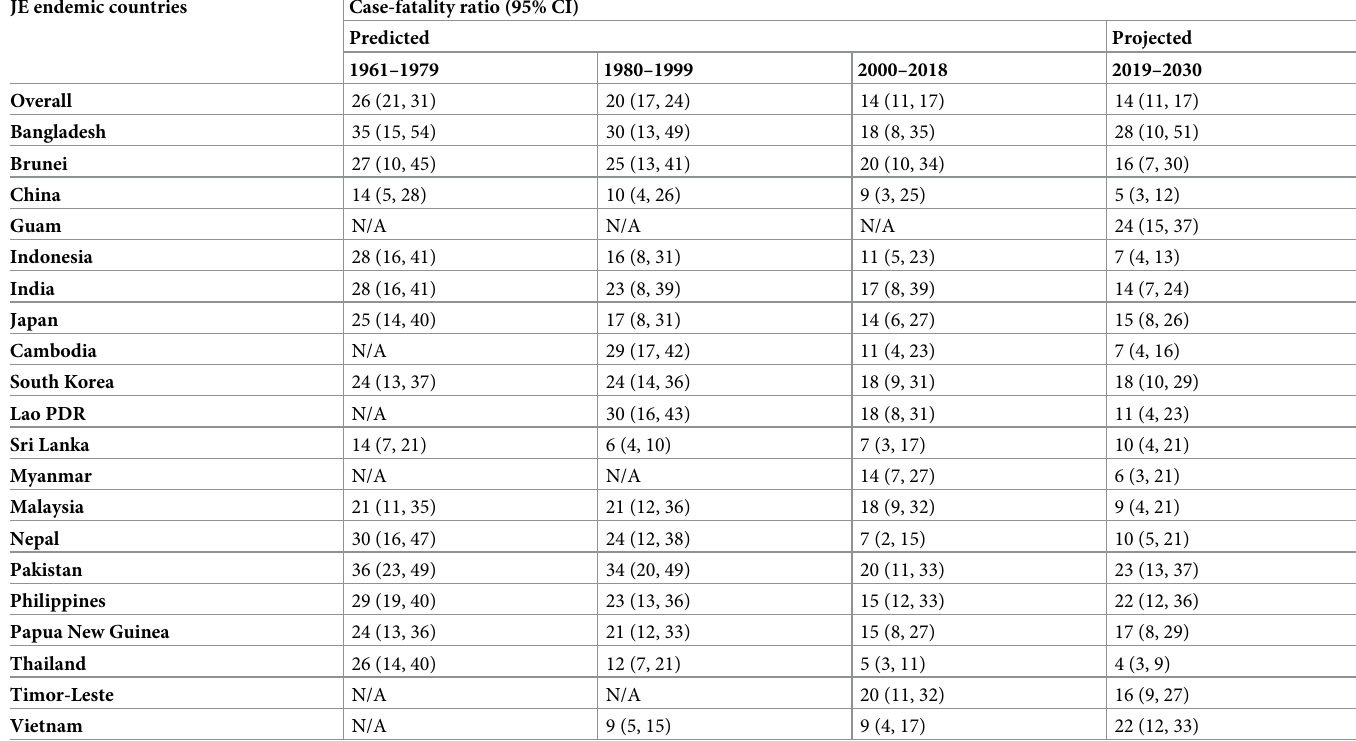
Table 4. Table of estimated Japanese encephalitis (JE) case-fatality ratio (CFR) estimated by the stacking model (model 6) without including year as predictor for 20 out of 24 JE endemic countries from 1961 to 2030. Country-specific and year-stratified JE CFRs and their associated 95% CI were presented. Areas with N/A values for JE CFR predictions had at least one unavailable socioeconomic